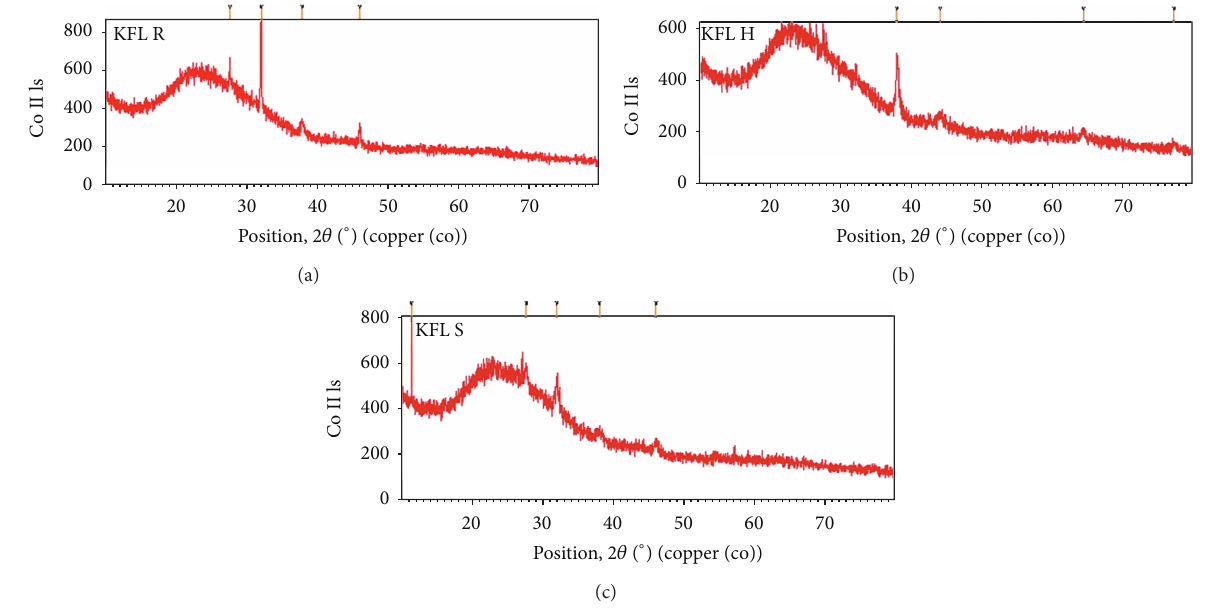
Figure 2: XRD spectra of synthesized silver nanoparticles using KFL extract under room temperature (a), higher temperature (b), and sonication (c).